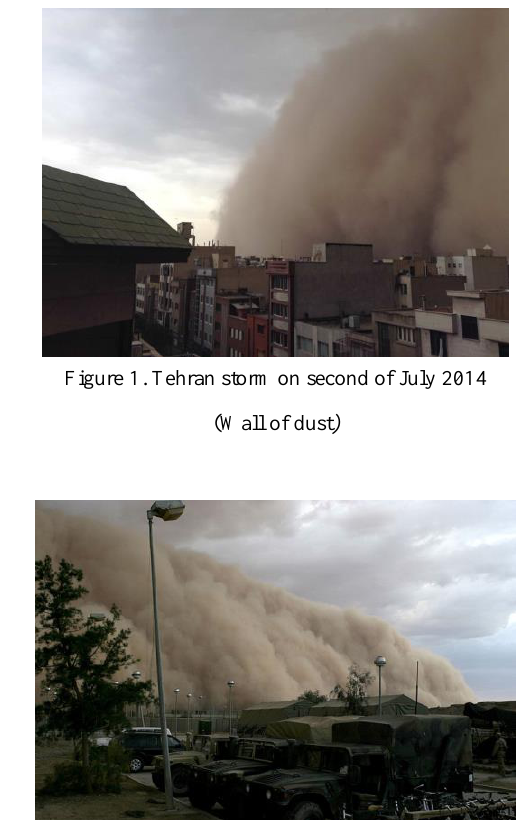
Figure 2. A massive haboob is close to enveloping Al Asad Airbase, Iraq, just before nightfall on 27 April 2005 (Wikipedia, 2014).